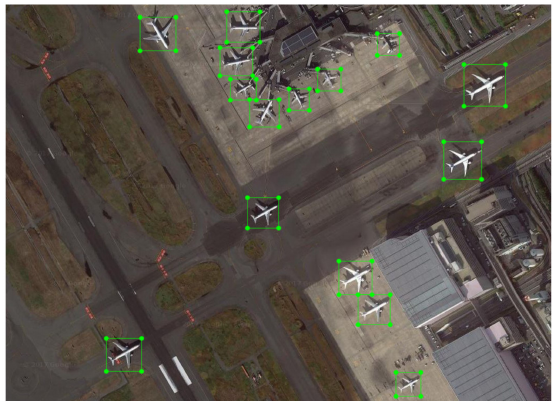
Figure 3. The annotated airplane samples.